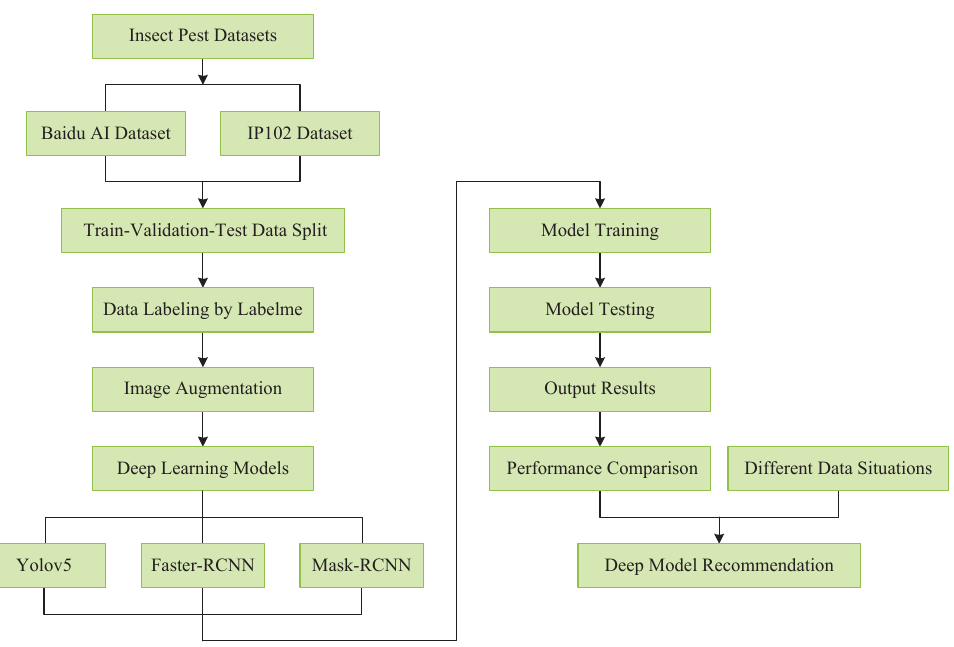
Figure 18. The overall flow chart of this